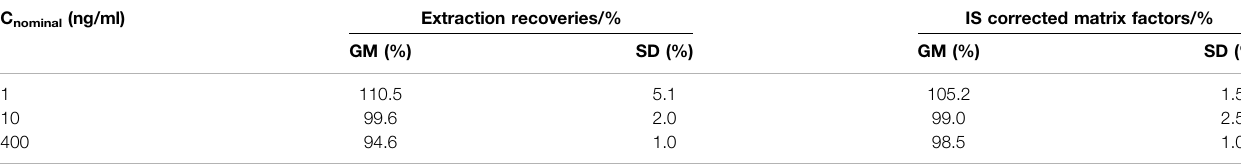
TABLE 2 | Recovery rates and matrix effects of the TFV in human breast milk. C nominal (ng/ml)